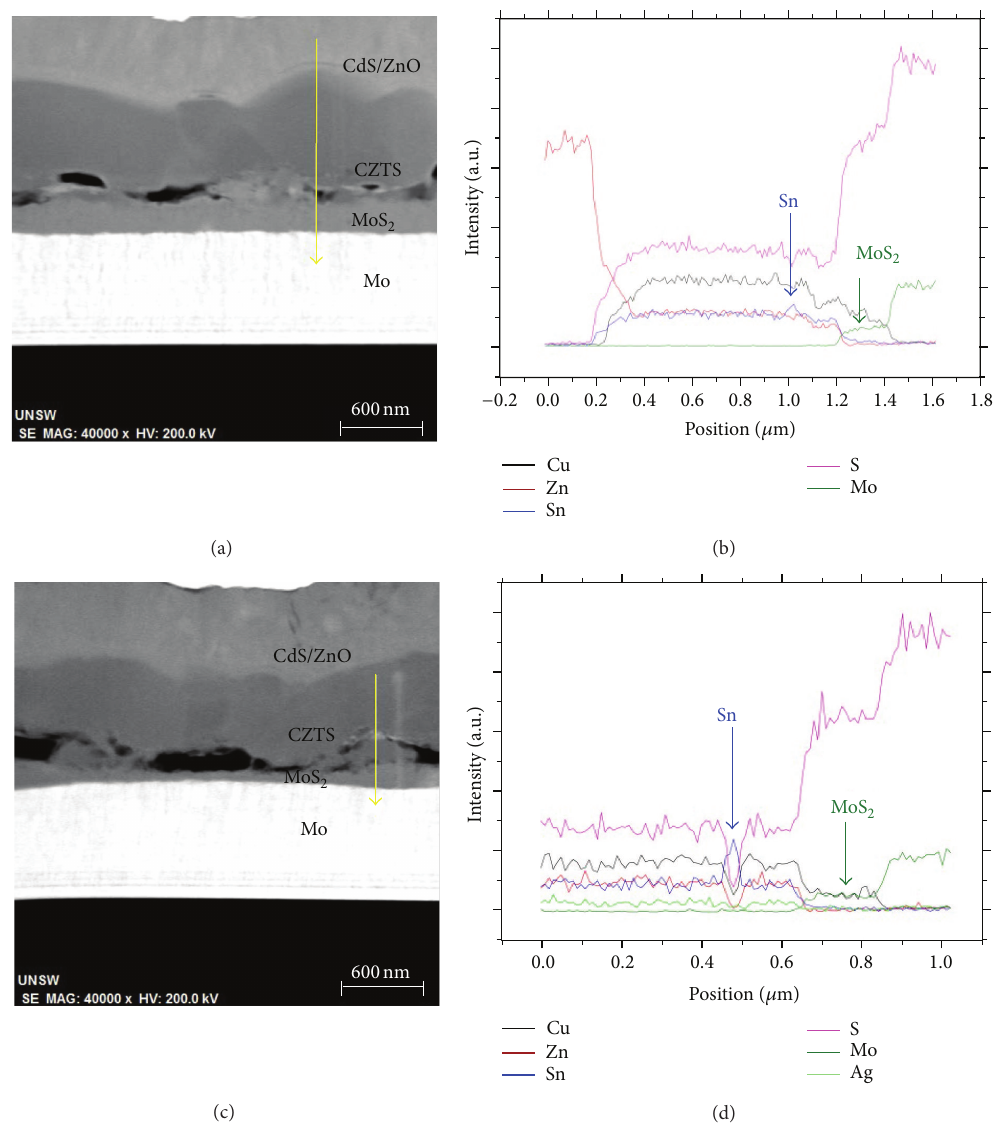
Figure 2: HAADF image of CZTS solar cells without (a) and with (c) Ag intermediate layer. The yellow arrow denotes the direction of an EDS line scan; (b) and (d) elemental profiles measured by the EDS line scans which are defined by the yellow arrow in (a) and (c),